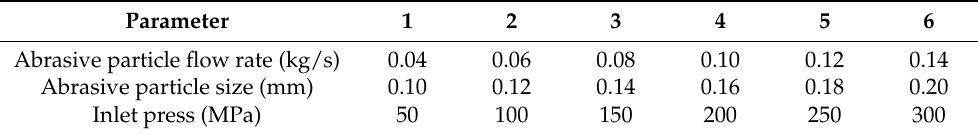
Table 9. Levels of system operating